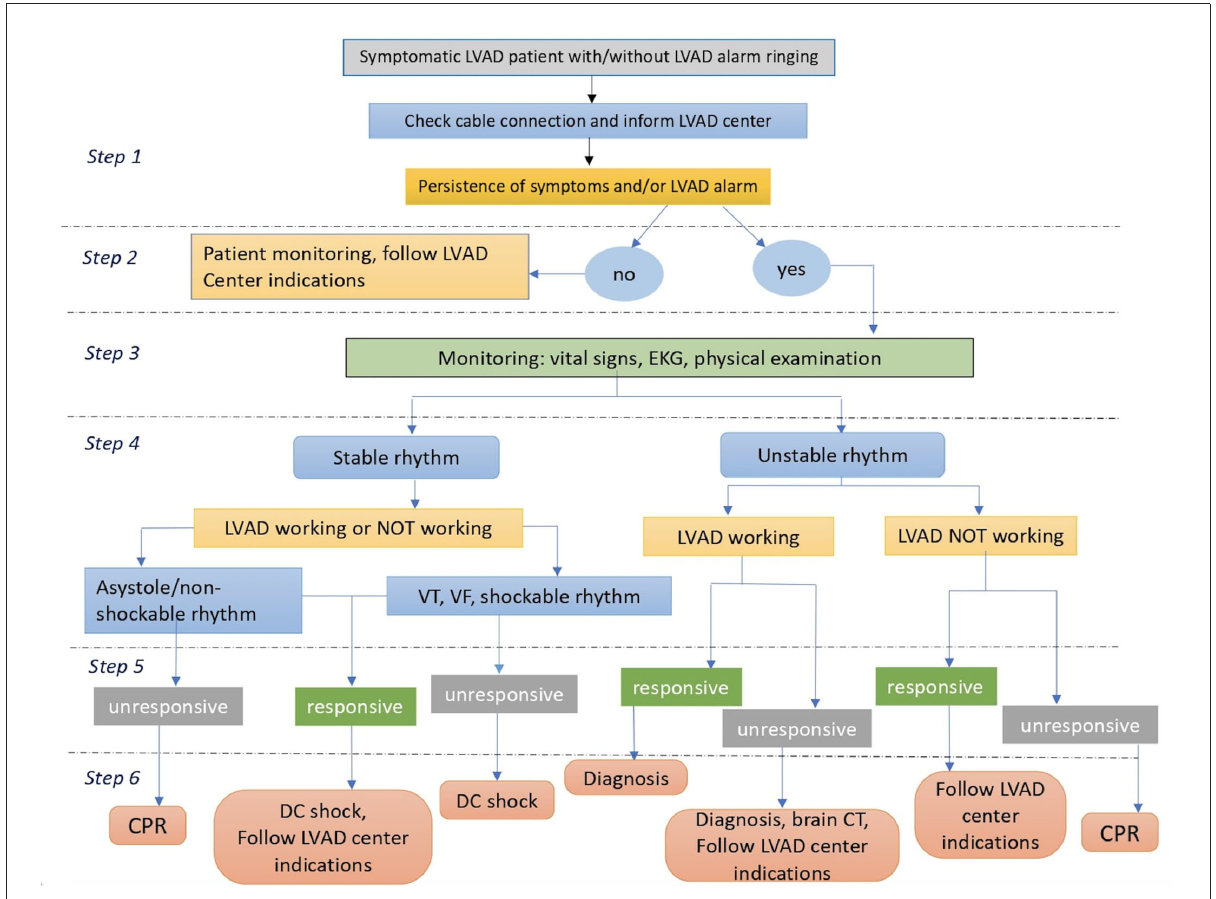
FIGURE1 An algorithm for emergency management of patients with LVAD. CPR, cardiopulmonary resuscitation; DC, direct current; LVAD, left ventricular assist device; VF, ventricular fibrillation; VT, ventricular tachycardia; ED, emergency